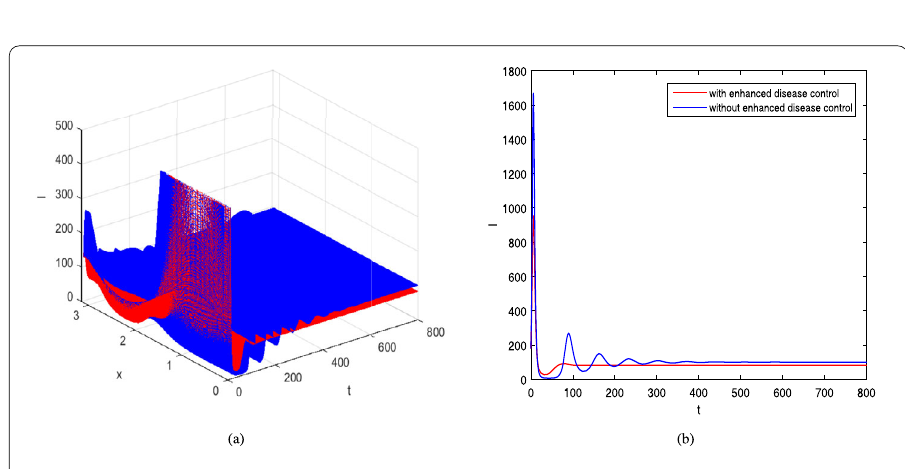
Figure 4 Simulations for numbers of the infected individuals I ( x , t ) of system (2.1) with threshold I c control (blue) and without threshold I c control (red) in the case 1 < R c < R 0 . ( a ) I ( x , t ) at x ∈ [0, π ]; ( b ) I ( x , t ) at x = π